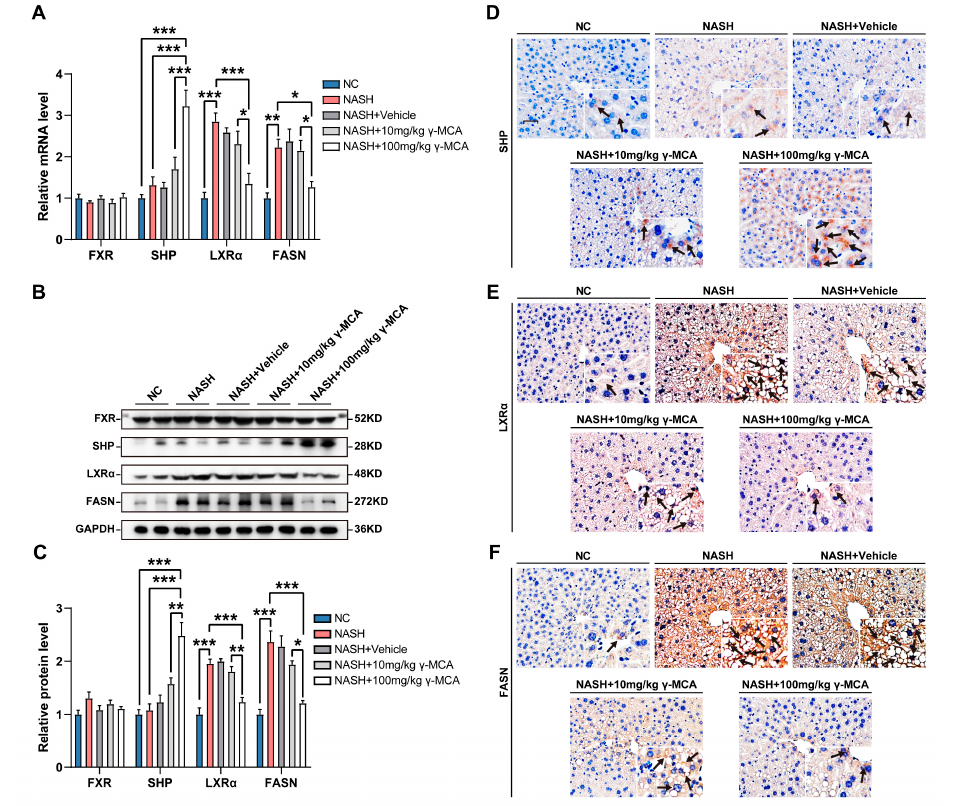
Figure 6. γ -MCA activated FXR/SHP/LXR α /FASN signaling in vivo. ( A ) The SHP was transcriptionally activated by the 100 mg/kg γ -MCA-based activation of FXR, and then inhibited the HFHC diet-induced expression of LXR α and FASN. ( B , C ) Western blot ( B ) and semi-quantitative analysis ( C ) revealed that SHP was upregulated upon the 100 mg/kg γ -MCA treatment, accompanied by the downregulation of LXR α and FASN expression. ( D – F ) Immunohistochemical staining verified the induction of SHP ( D ) and the expressive inhibition of both LXR α ( E ) and FASN ( F ) in hepatocytes after 100 mg/kg γ -MCA treatment (scale bar: 25 μ m). Arrows indicate the positive parts of hepatocytes. The data were presented as the mean ± SEM. *, p < 0.05; **, p < 0.01; and ***, p < 0.001.